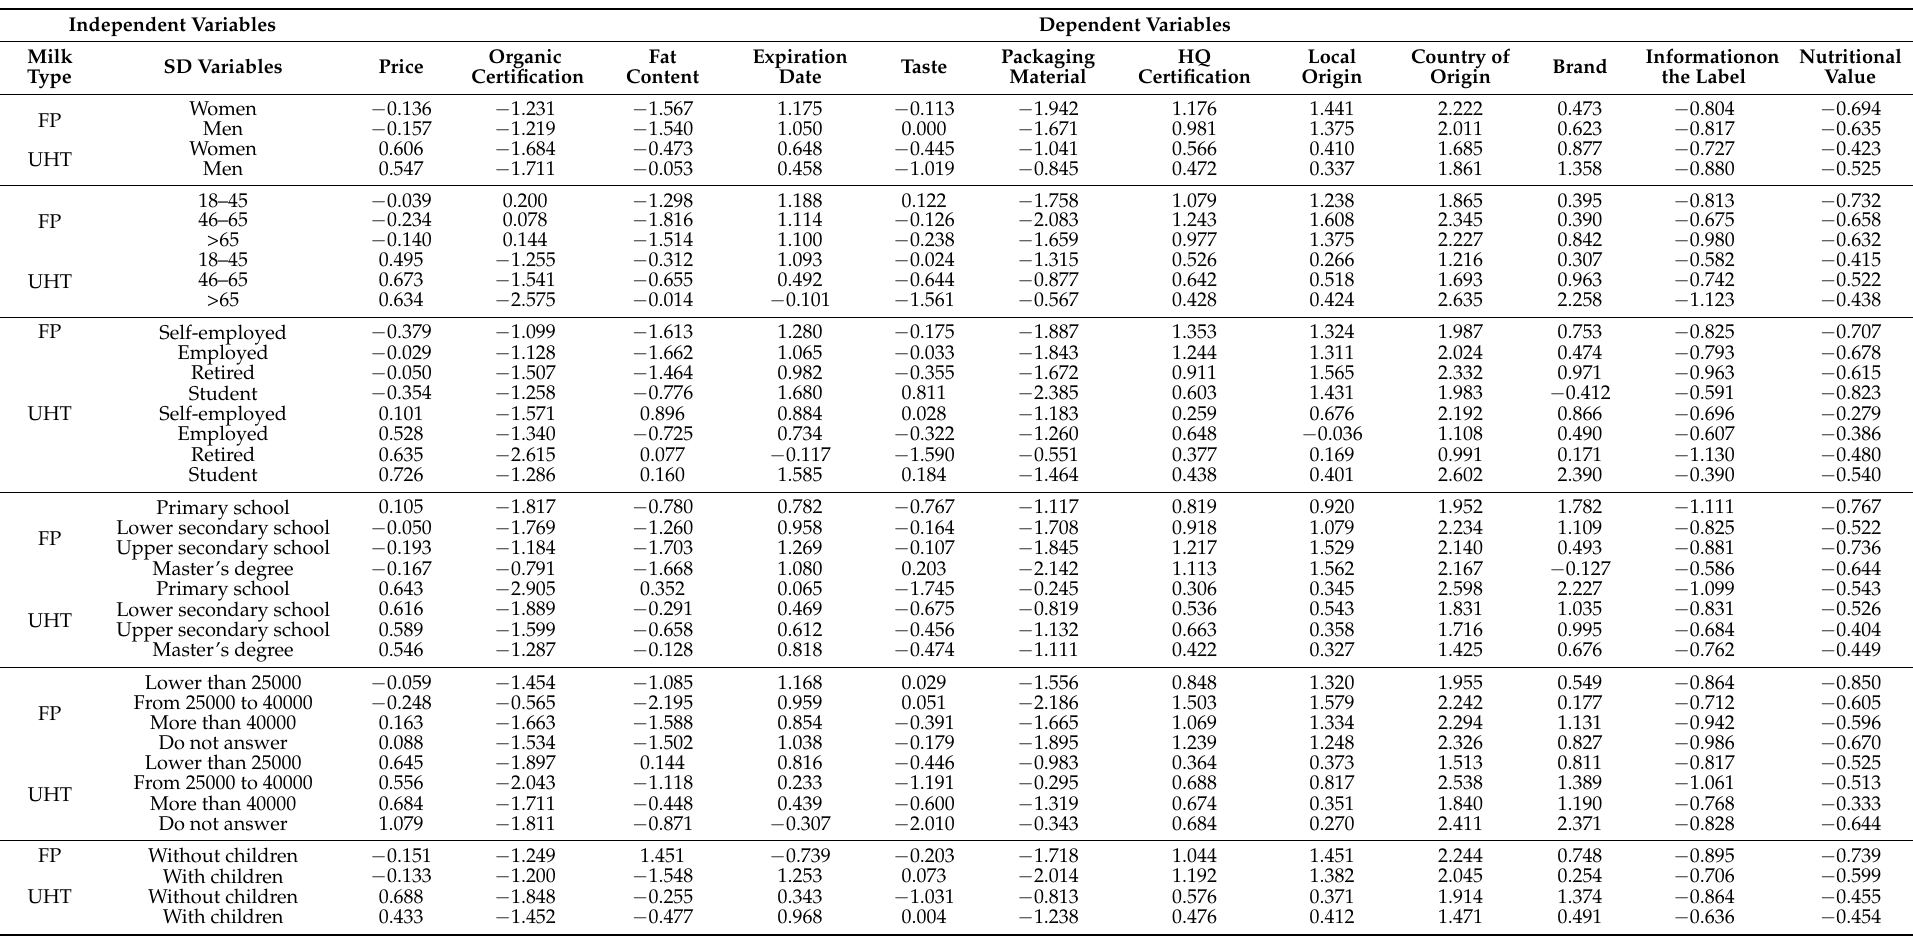
Table 3. Differences of the average raw scores (preferences level) for each milk attributes considering the effect of the type of milk chosen (fresh pasteurised, FP; ultra-high temperature, UHT treated milk) and the individuals’ socio-demographic (SD) characteristics